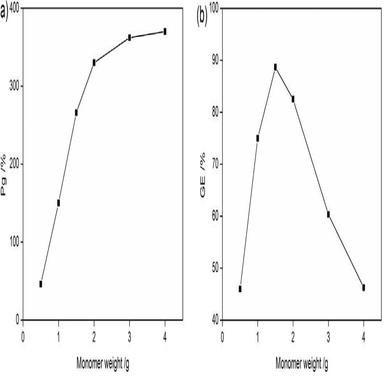
Effect of monomer amount on the Pg (a) and GE (b) of grafted copolymer: Weight of PG = 0.5 g, concentration of initiator (PPS) = 2 mmol/L, t = 180 min, T = 50 °C.